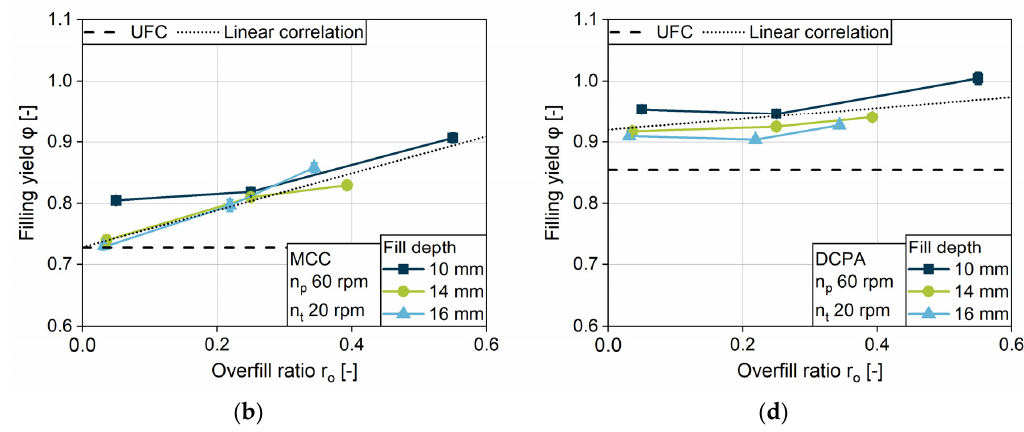
Figure 13. Filling yield at overfill ratios for the three fill depths at a turret speed of 20 rpm for MCC at a paddle speed of 20 ( a ) and 60 rpm ( b ) and, for DCPA, at a paddle speed of 20 ( c ) and 60 rpm ( d ).